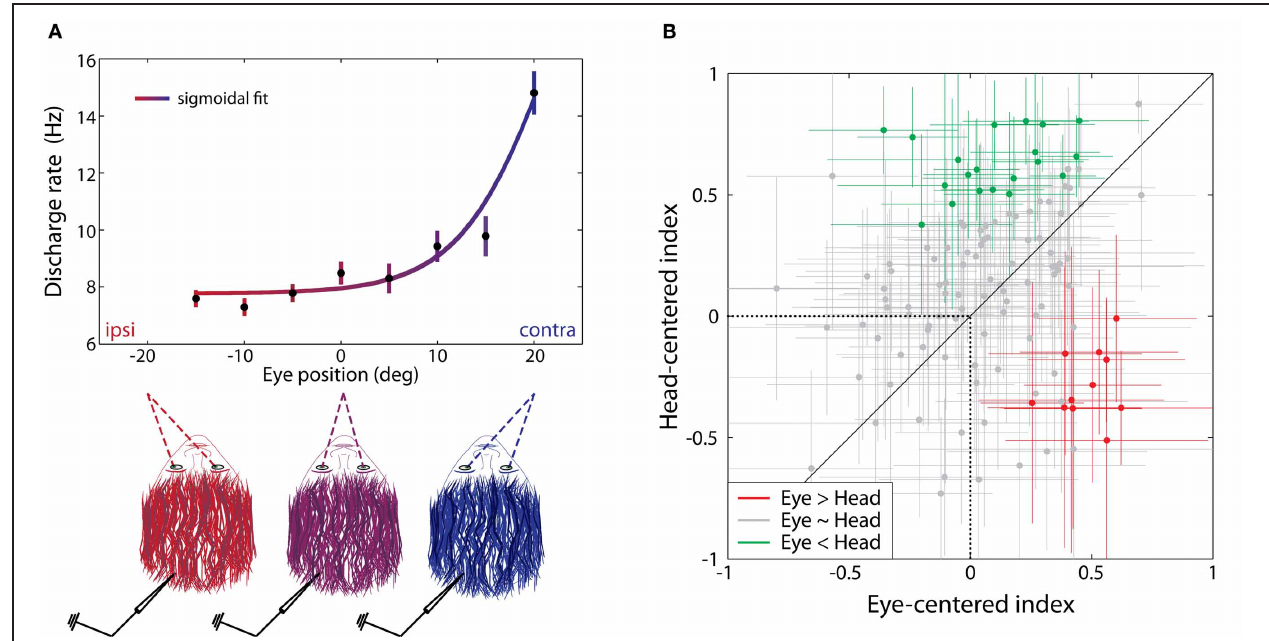
A value of 1 indicates that the response function of a cell is perfectly aligned with the sound source in a particular reference frame (eye-centered or head-centered), while a value of − 1 indicates perfect anti-correlation. Crosses centered on individual points indicate 95% confidence intervals for reference frame values. The reference frame of individual cells may be more head-centered (green) or eye-centered (red), or cells may have a hybrid reference frame (gray). (B) Reprinted from Porter et al.